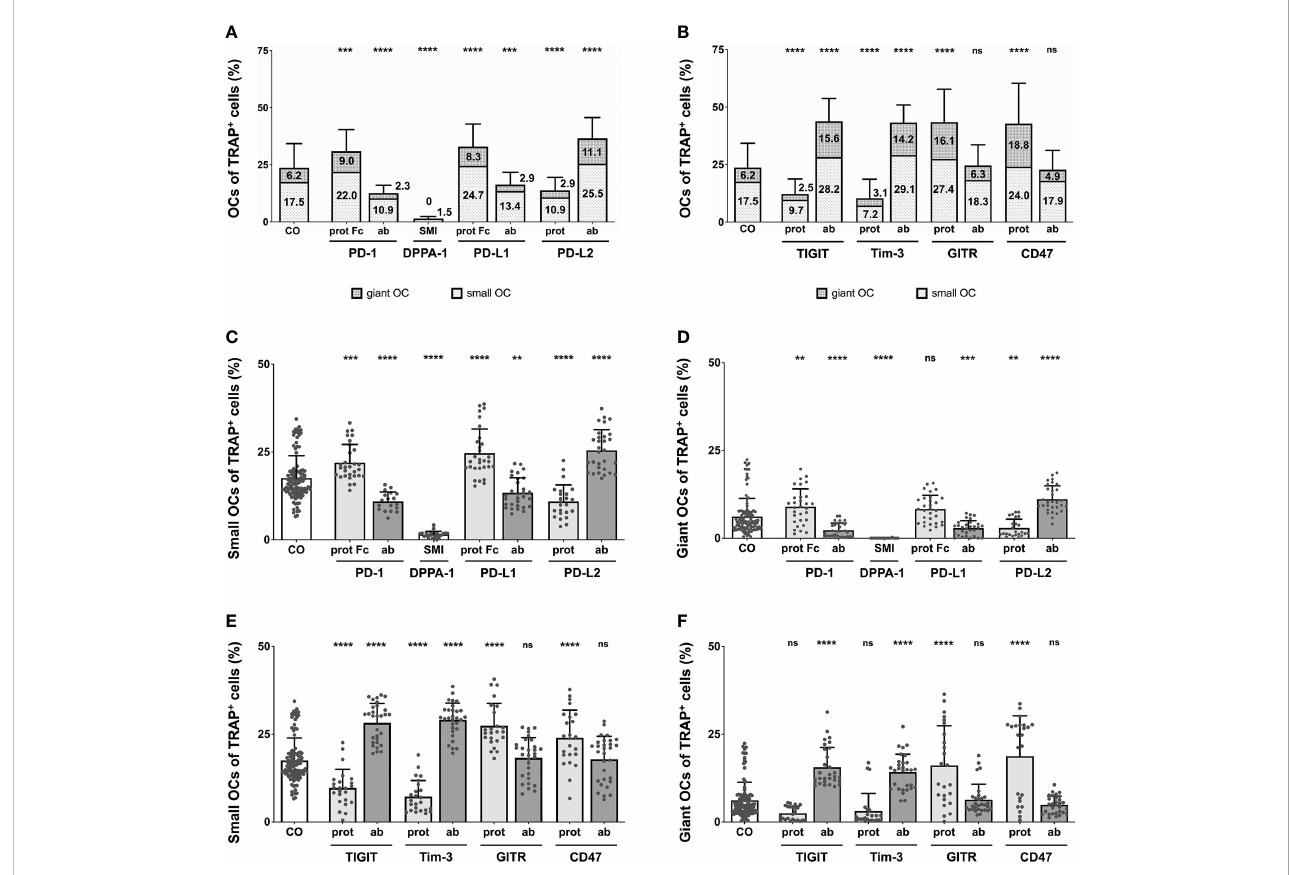
FIGURE 3 Analysis of the proportions of OCs of TRAP + cells under various treatment condition. (A, B) OCs of TRAP + cells as counted in the six squares (each measuring 1 mm 2 ) per culture well. Columns are made up of the proportions of small OCs (TRAP + , 3 – 10 nuclei) and giant OCs (TRAP + , >10 nuclei) and labelled with the percentual values, respectively. Signi fi cance and standard deviation bars refer to the proportion of total OCs. (C, E) Small OCs and (D, F) giant OCs were counted separately in each square. Signi fi cance and standard deviation bars refer to proportions of small and giant OCs, respectively. Each data point represents the percentage of (A, B) all, (C, E) small, (D, F) giant OCs of TRAP + cells, analyzed in a square of 1mm 2 , of which 6 were assessed per culture well. Columns show mean and standard deviation. Asterisks indicate level of signi fi cance in comparison to CO, set at P < 0.05 (** < 0.01, *** < 0.001, **** < 0.0001; ns, non-signi fi cant). All data is acquired from at least 3 independent experiments, each with a minimum of 2